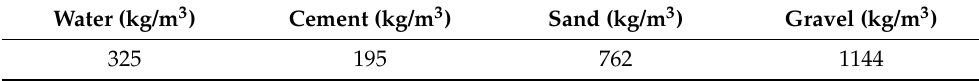
Table 2. Mix proportion of